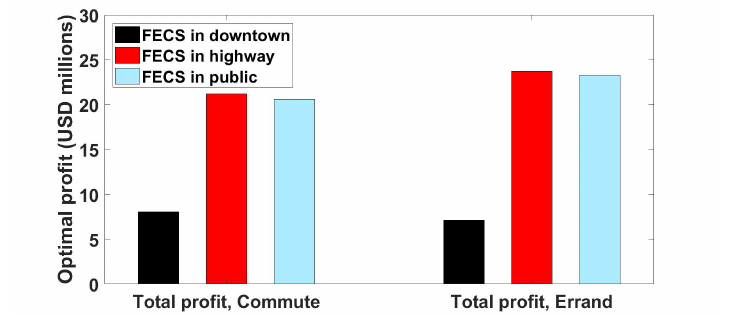
Figure 9. FECS optimal profit by